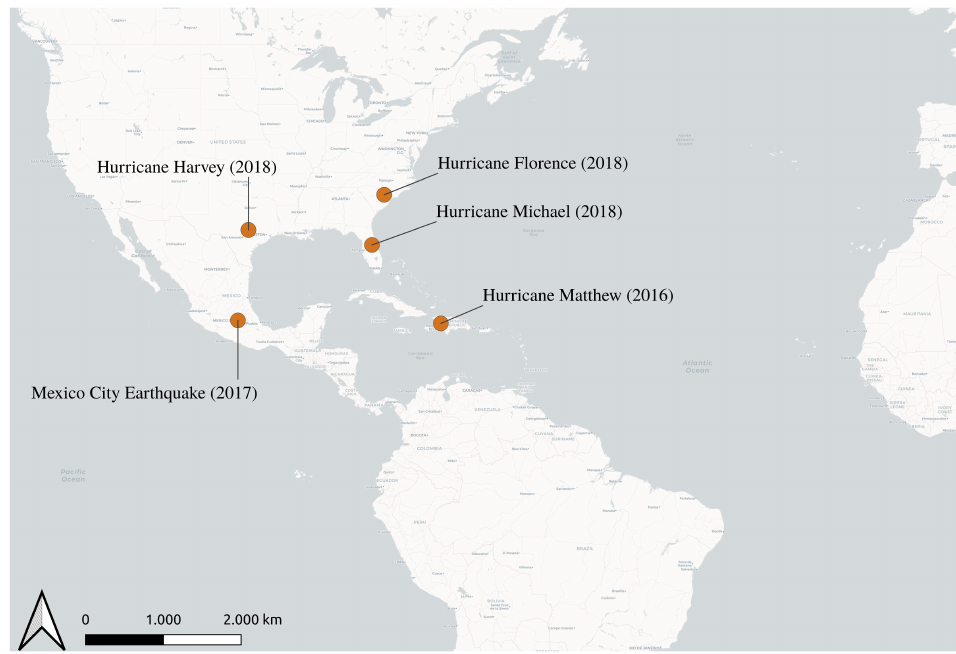
Figure 1. The disaster incidents in the training